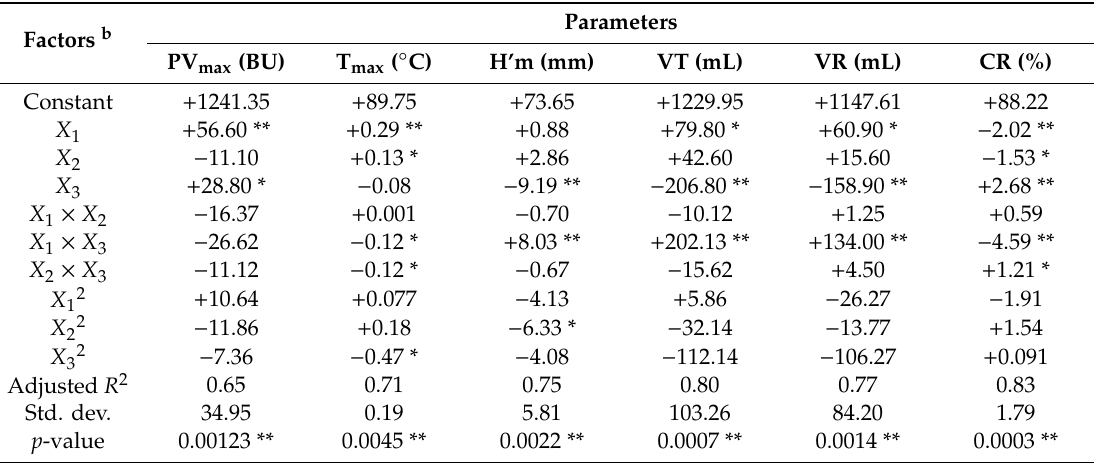
Table 5. The e ff ects of independent variables (SS, SD and FS), expressed as their coe ffi cients on the predictive mathematical models for the rheological parameters of the dough during pasting and fermentation of sea salt–dry sourdough–fermented sugar mixtures. Factors